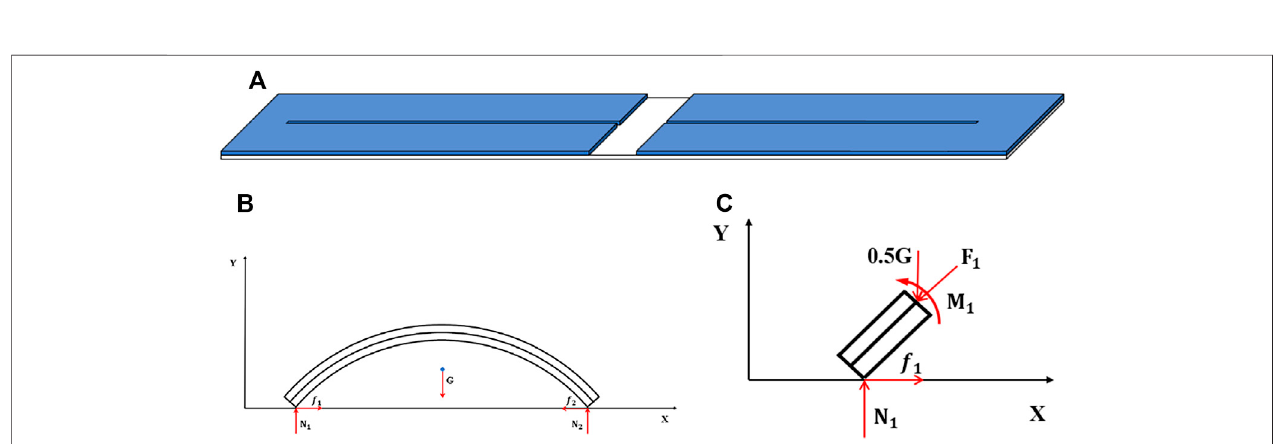
FIGURE 5 | (A) Sketch of an inchworm-inspired soft crawling robot. Force analysis of (B) the whole crawling robot and (C) an in fi nitesimal segment at the left